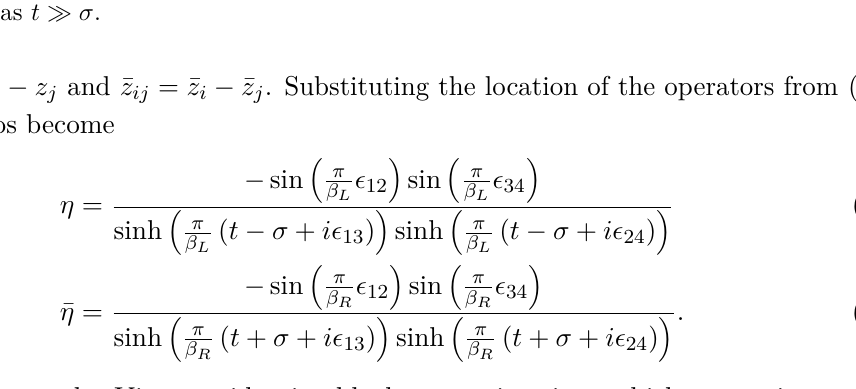
Figure 1 . The blue curve denotes t < σ , at t = σ the holomorphic cross-ratio crosses branch cut running from η = 1 to ∞ and enters the second sheet where the green curve denotes t > σ and η becomes small as t (cid:29) σ